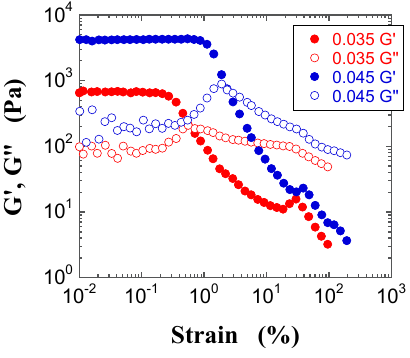
Figure 9. Double-logarithmic plots of G' (filled circles) and G" (open circles) for the PS suspensions at φ = 0.035 (red) and 0.045 (blue) as a function of strain.